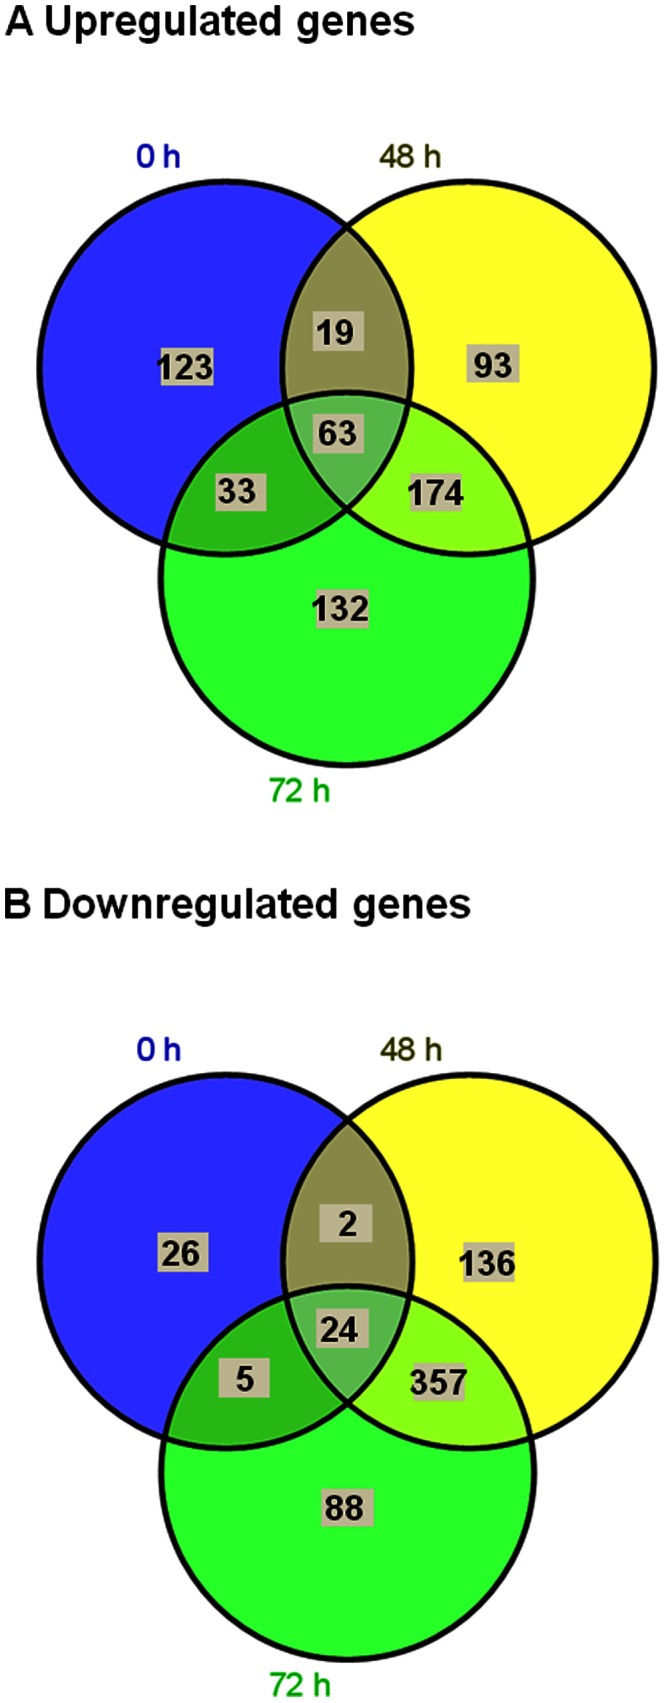
Venn diagrams indicating the differentially expressed genes in the zebrafish liver during the transport process.The number of upregulated (A) and downregulated (B) genes immediately after packing (0 h) and at 48 and 72 h during transport compared to the values prior to transport (basal) are marked inside each circle. The genes which have ≥2 fold change in at least one of the pair wise comparisons (between the time points) and significantly altered (P<0.05) compared to basal values are included for each time point.